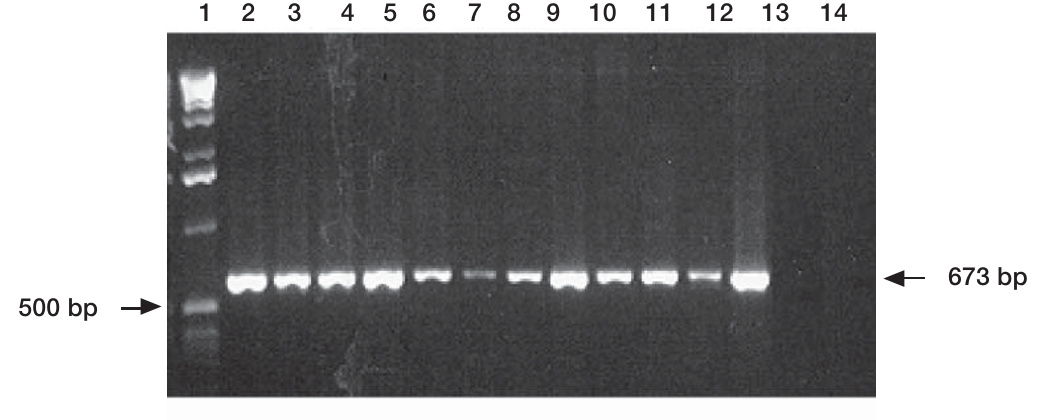
Fig. 1. Agarose gel (1%) electrophoresis of CP DNA amplicons obtained from tomato samples using CPc and CPv primers. Sources of nucleic acids are as follows: lane 1, ladder (1 kb [BRL]); lane 2, coat protein gene of the Egyptian isolate; lanes 3 to 13 correspond to TYLCV-Bn/Bz/Cb/Ch/Dk/Ge/Ha/Mk/Pim1/Pim2 and TYLC-Tb amplified CP re- gion; lane 14, healthy